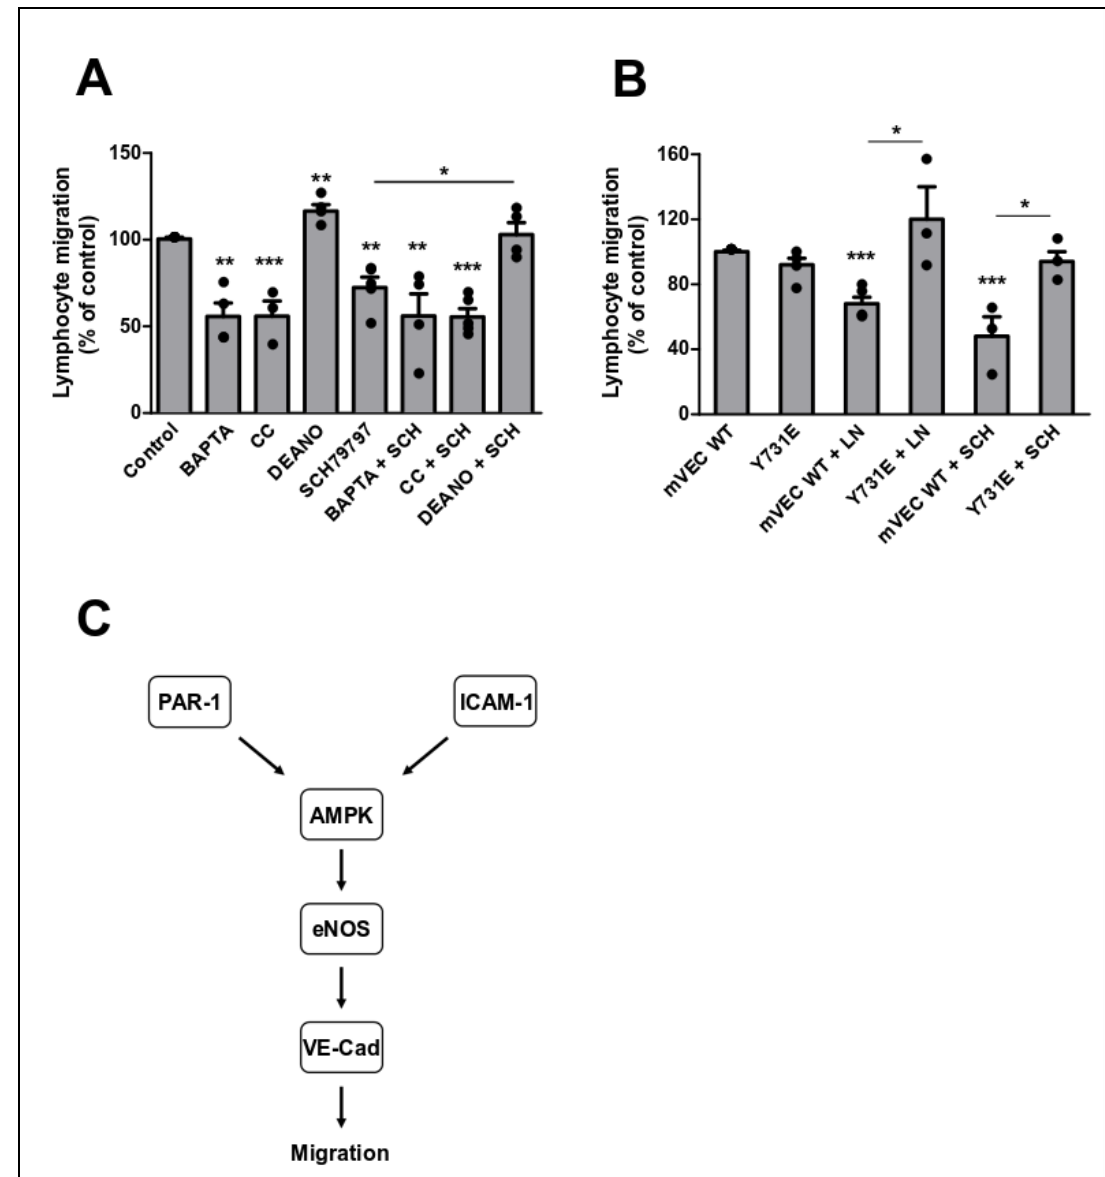
Figure 6. NO and VE-cadherin are downstream of PAR1 in TEM-regulating endothelial signalling. ( A ) GPNT were pre-treated for 2 h and maintained with BAPTA (20 µM), compound C (CC, 10 µM), DEANO (50 µM) or SCH79797 (1 µM) and the indicated compound combinations. PAS were added and TEM was assessed 4 h. ( B ) GPNT were transfected with either pEGFP-N’-mVEC WT or Y731E encoding wild type mouse VE-cadherin or the phosphomimetic mutant Y731E and grown to confluency for 24–48 h. GPNTs were then either left untreated (mVEC WT, Y731E) or pre-treated with and maintained in PAR1 non-peptide antagonist SCH79797 (SCH, 1 µM) for 2 h. L-NAME pre-treatment (LN, 1 mM) was administered 1 h before PAS were added to the monolayer. Data represented as normalised means -/+ SEM. Each data point represents one independent, biological replicate. Significant differences were determined by ANOVA and Tukey’s post-hoc analysis (v control or pairwise as indicated). * p < 0.05, ** p < 0.01, *** p < 0.001. ( C ) Proposed signalling network downstream of PAR-1 and ICAM-1.